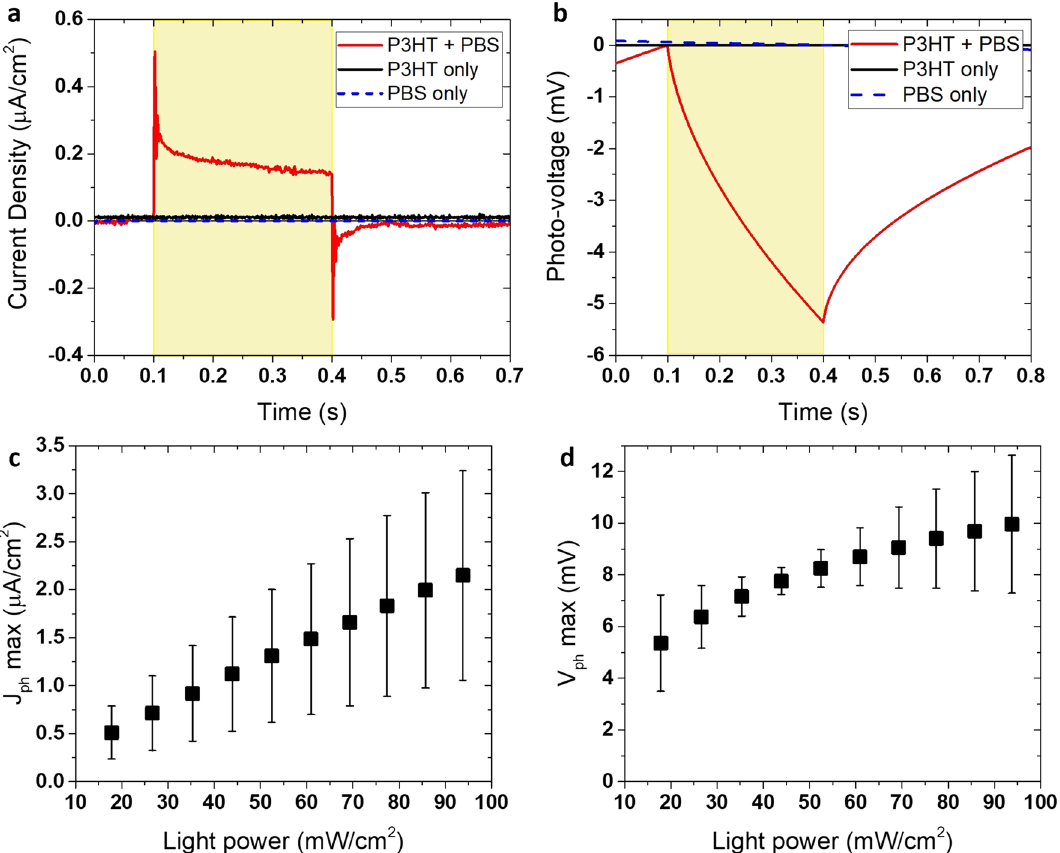
Figure 2. Bio-hybrid device optoelectrical characterization. ( a ) Transient current density generated by 300 ms white light stimulus (17.8 mW/cm 2 ). ( b ) Transient photo-voltage recorded from the device under 300 ms white light (17.8 mW/cm 2 ) stimulus. ( a , b ) black line: device containing only polymer thin film; dashed blue line: device containing only electrolyte solution; red line: device containing polymer (P3HT) and biological electrolyte (PBS). The shaded yellow area represents the duration of the light stimulus (300 ms). ( c ) Current capacitive peaks (J ph max) show a linear dependence with the light power intensity. Plot is referred to J ph first positive peaks. J ph values are the mean on samples n = 3. Y-error bar is also shown. ( d ) Photo-Voltage as function of increasing light intensities. V ph max values (in absolute value) are referred to the value reached after 300 ms from the light switched ON. Radiant intensities used for J ph and V ph : 17.8, 26.6, 35.3, 43.9, 52.4, 60.9, 69.3, 77.4, 85.7, and 93.8 mW/cm 2 . (OriginPro 2016 was